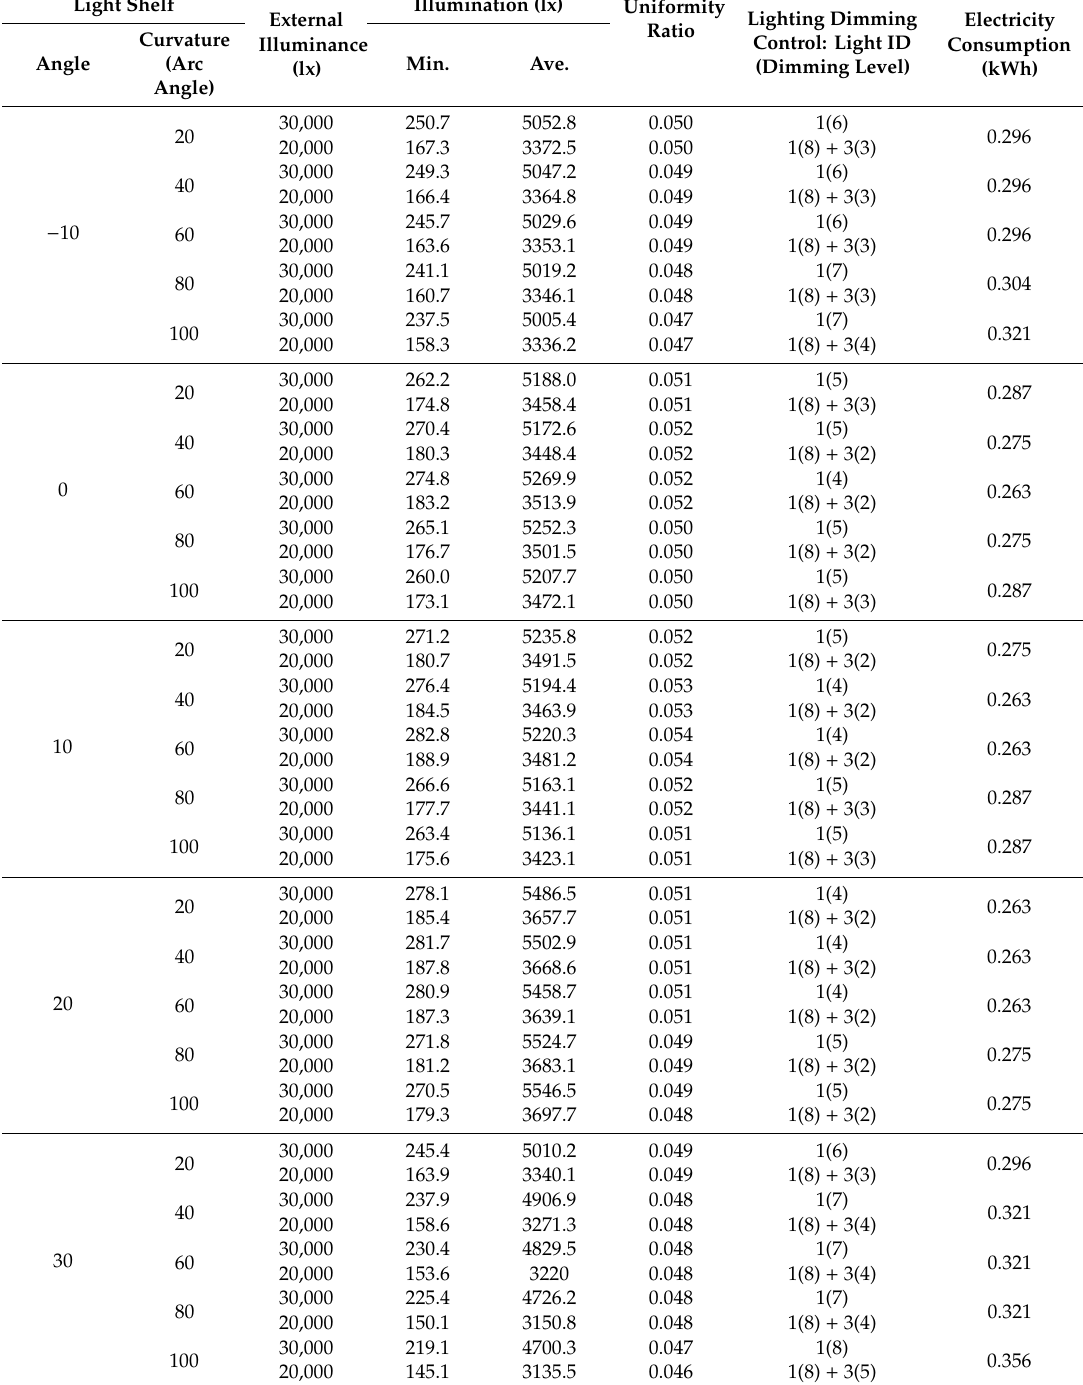
Table 10. Performance evaluation results for curved light shelf during